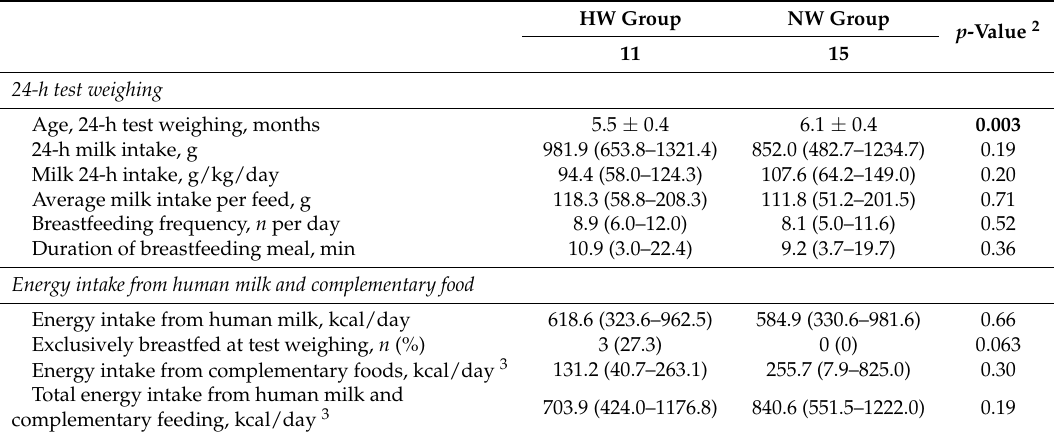
Table 3. Intake of human milk and complementary food at 5–6 months, in the high weight gain and normal weight gain group 1 .